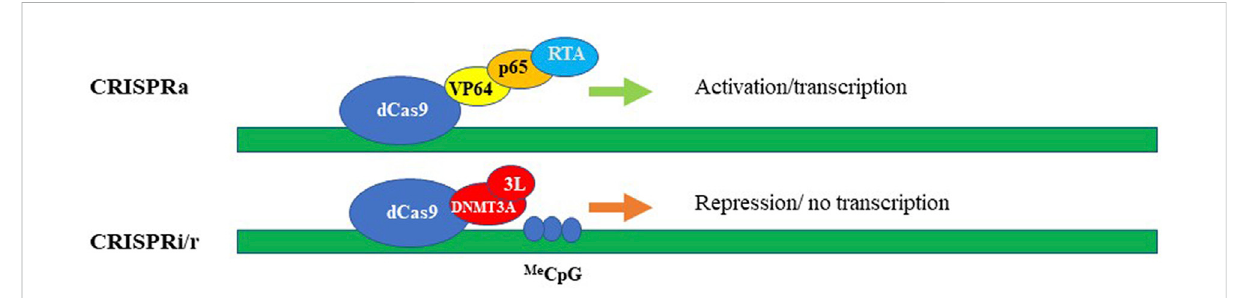
FIGURE 3 CRISPRa (activation) and CRISPRi/r (interference/repression). The synthetic activators (upper panel) comprise of dead/inactive Cas9 (dCas9) fused with transcriptional activators, e.g. VP64, p65, and RTA encoded by Epstein-Barr virus (EBV). Transcriptional repression (lower panel) schematically represented by dCas protein fused with DNA methyltransferase, here, DNMT3A and DNMT3L. The methylated DNA could be then repressed via the cascade of DNA-methylation mediated